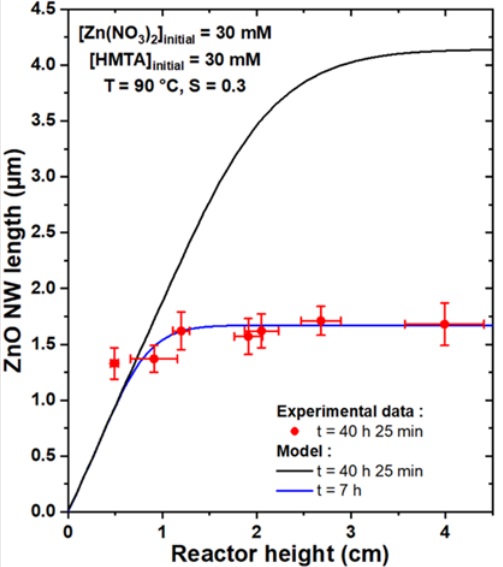
Figure 5. Length, L, vs. reactor height, h, of ZnO NWs grown by CBD at 90 °C with 30 mM of Zn (NO 3 ) 2 and HMTA for 41 h (corresponding to an effective growth time of 40 h and 25 min). The experimental data were fitted by the theoretical model, using C 0 = 19.1 mM, C eq = 15.2 mM, k 1 = 18.2 μ m/s, S = 0.30, D = 2.74 ×10 − 9 m 2 /s, and ρ = 4.20 × 10 28 m − 3 . The best adjustment is reached when an effective growth time of 7 h is considered, whereas the length of ZnO NWs is greatly overestimated if the expected effective growth time of 40 h and 25 min is instead considered.